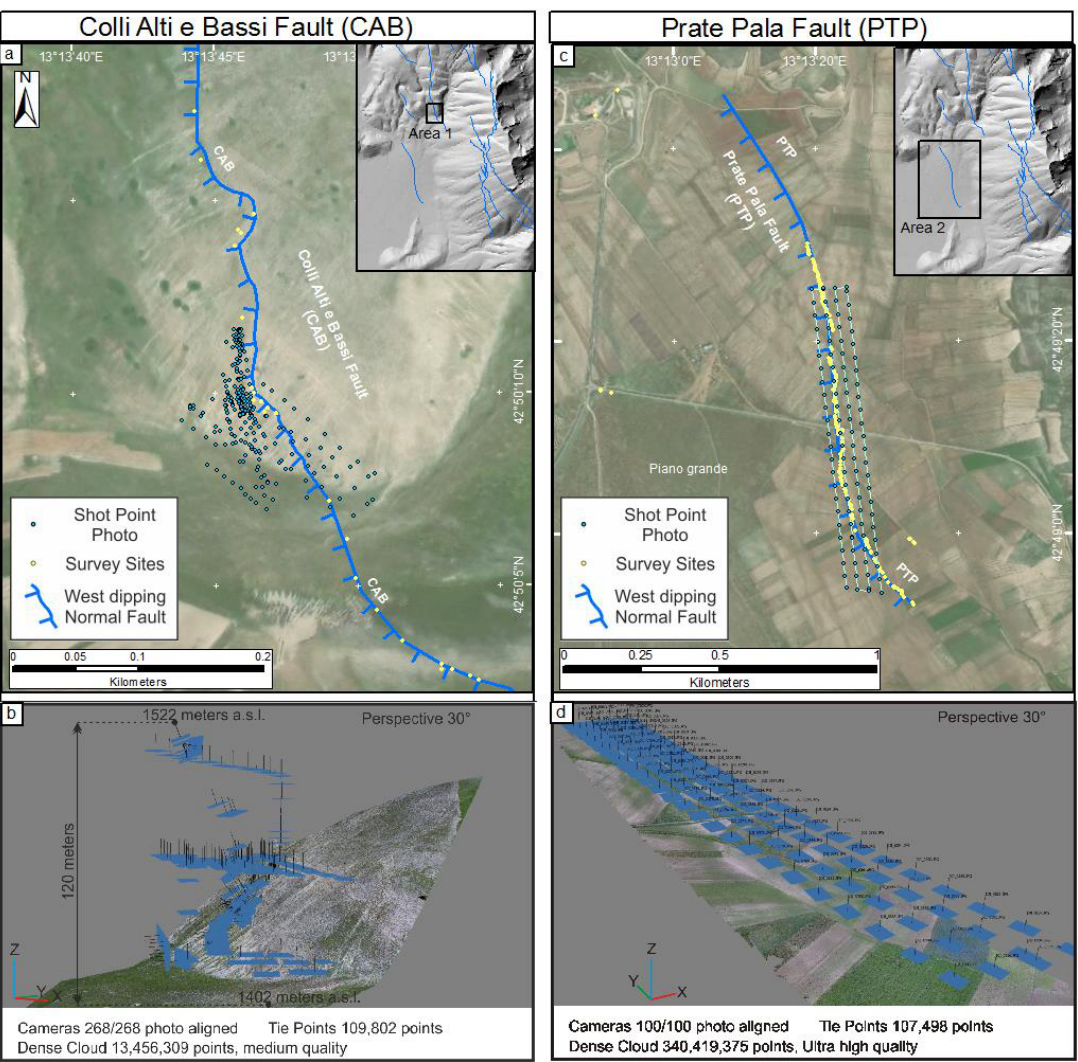
Figure 2. ( a , b ) Sample area 1, along the Colli Alti e Bassi Fault (CAB, location in Figure 1b); the two sketches ( a = plan view, b = bird’s eye view) illustrates the mission flight plan for image capturing over the sample area using a manual flight, with an overlap of 80% along the path and 80% in a lateral direction, useful to have a good alignment of images and to reduce the distortions on the resulting orthomosaics; ( c , d ) Sample area 2, along the Prate Pala Fault; (PTP, location in Figure 1b) the two sketches ( c = plan view, d = bird’s eye view) illustrates the mission flight plan for image capturing that covers the area using north-south flight paths with 65% along the path and 60% in a lateral direction. Legend: blue point: shot point photo; yellow point: sites of manual and digital mapping; blue line: trace of the CAB ( a ) and PTP ( b ) faults; tics indicates the hanging wall block.